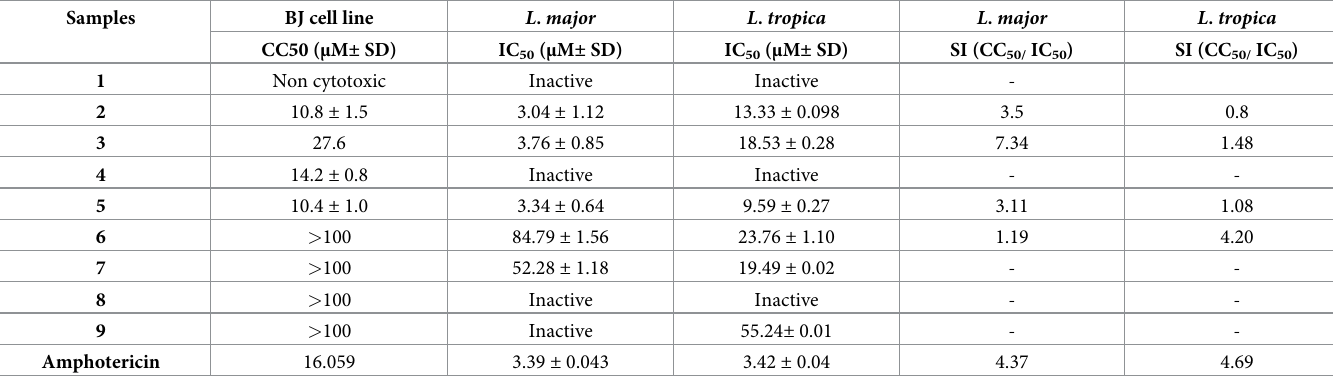
Table 5. Selectivity index of crude fractions against BJ fibroblast cell line.